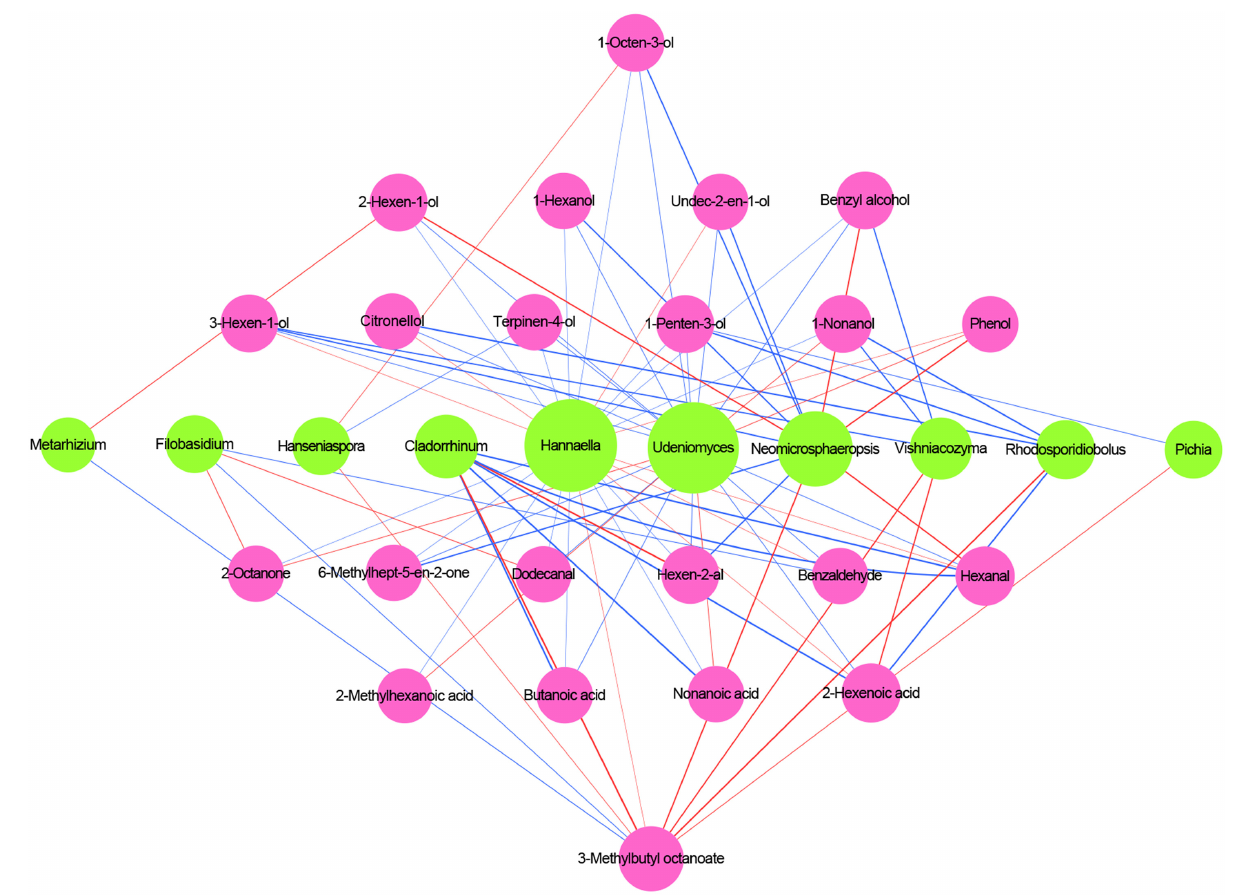
FIGURE 7 | Correlation analysis of microbiota and volatile compounds during spontaneous fermentation. Core fungal genera are shown in green and core volatile compounds are shown in purple. Blue lines indicate positive correlations, and red lines indicate negative